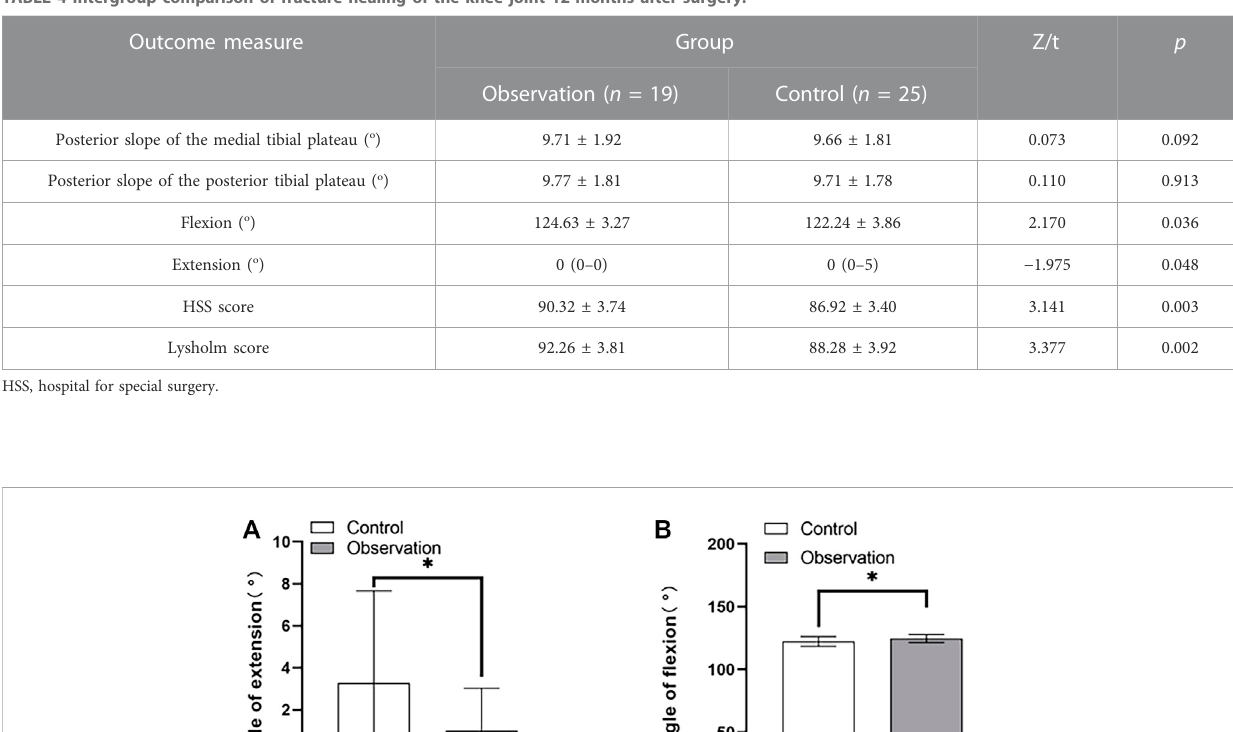
TABLE 4 Intergroup comparison of fracture healing of the knee joint 12 months after surgery.